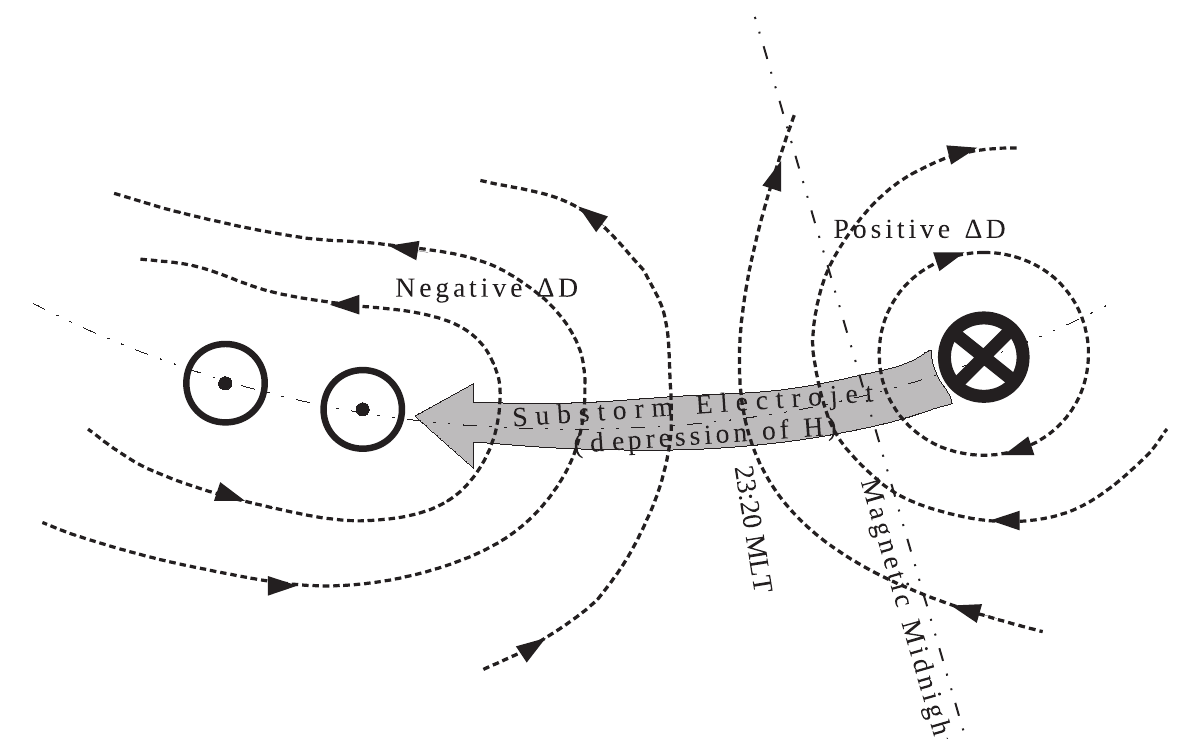
Fig. 4. The schematic sketch of the conditions of the Clementinum observatory during the magnetic storm on 17 November 1848. The circles with dots in their centres indicate the location of the upward FAC, the circle with a cross mark the position of the downward FAC. The intensity of the electric currents is expressed by means of the boldness of the markers. The dashed lines represent the lines of force of the magnetic fi eld generated by the FACs. The D D sign stands for the deviation of the magnetic declination. We suppose that the substorm electrojet then fl owed at a magnetic latitude which was lower than the magnetic latitude of